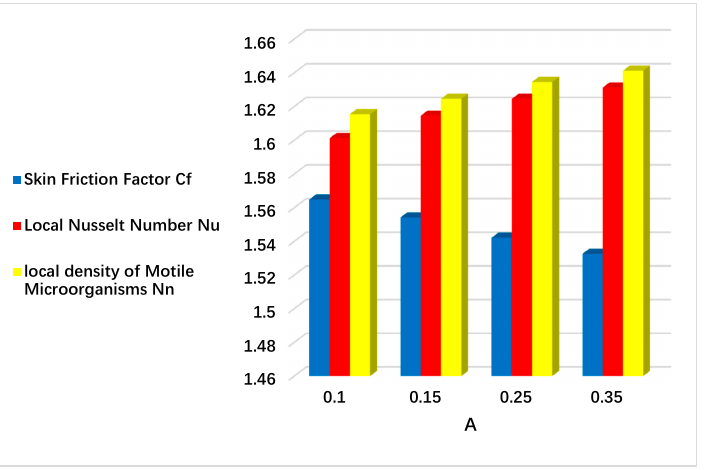
Figure 22. Influence of M on C f , Nu, and Nn . Coatings 2022 , 12 , x FOR PEER REVIEW